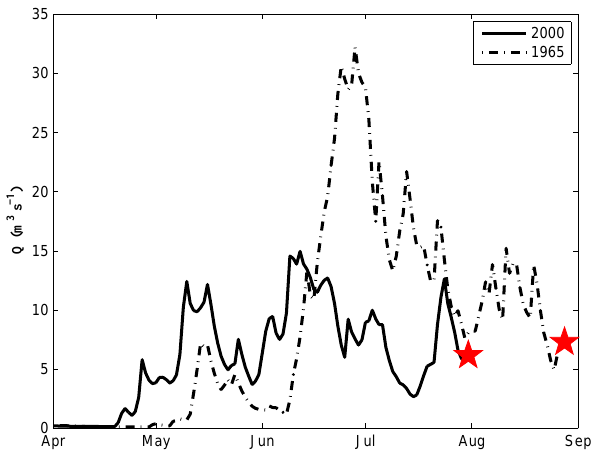
Fig. 14. Modelled runoff in 1965 and 2000. Stars indicate the oc- currence of the break-offs. In both cases, break-offs occurred after a period of runoff